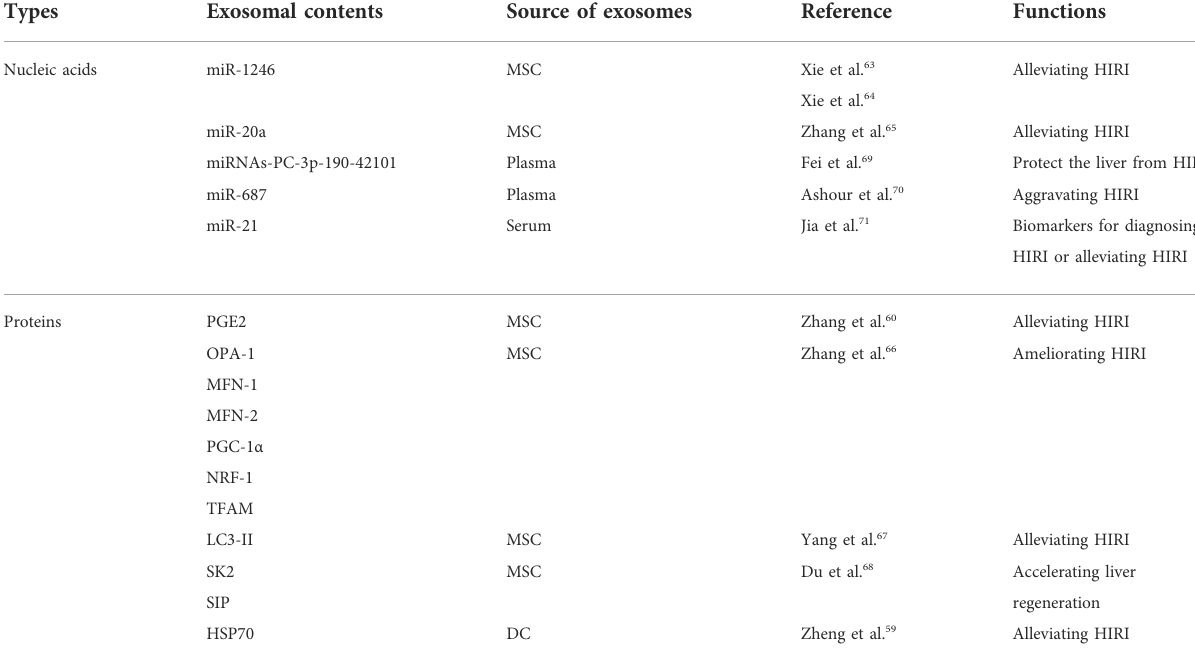
TABLE 2 Function of nucleic acids and proteins carried by exosomes on hepatic ischemia reperfusion injury.